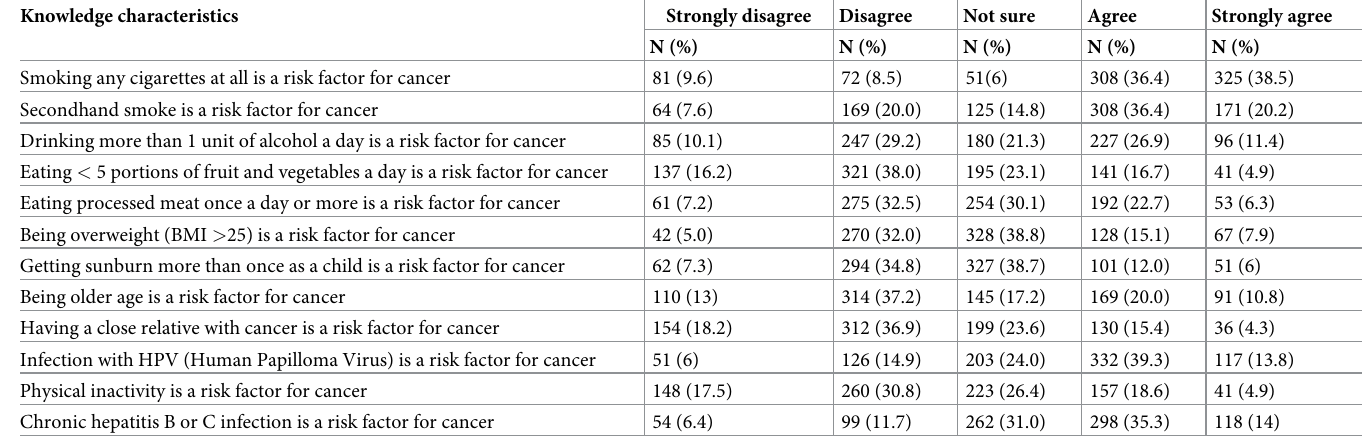
Table 3. Level of knowledge of the study participants toward cancer risk factors among Bahir Dar city residents, North West Ethiopia 2019, (n =